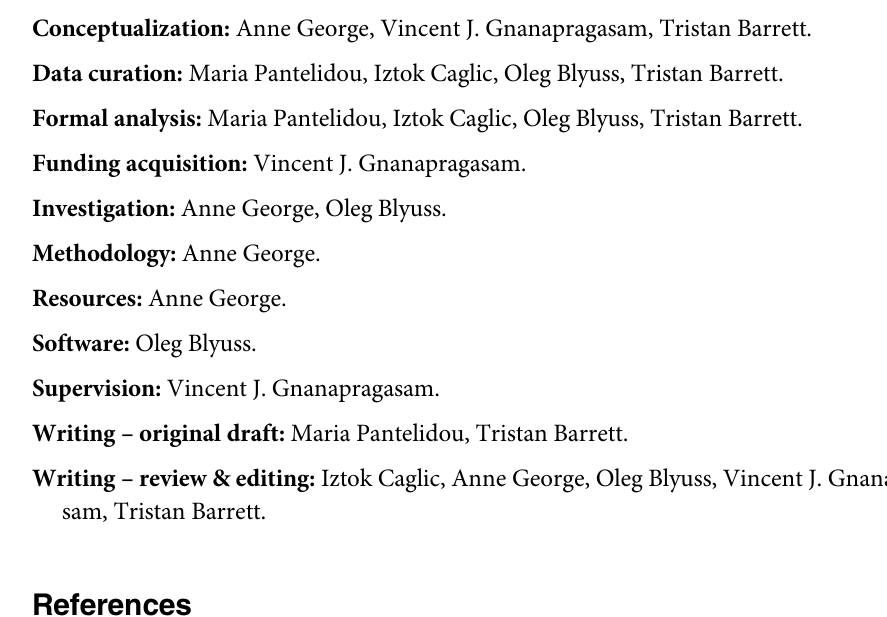
S1 Fig. Bland-Altman agreement of US-derived TP versus MRI-derived prostate volume. The middle solid line represents the mean agreement difference between MRI and US TP vol- umes, the lower line represents the lower limit of agreement between the two techniques ([mean– 1.96 standard deviation (SD) and the upper line represents the upper limit of agree- ment ([mean + 1.96 SD)] between the two techniques. S2 Fig. Bland-Altman agreement of US-derived TA versus MRI-derived prostate volume. The middle solid line represents the mean agreement difference between MRI and US TP vol- umes, the lower line represents the lower limit of agreement between the two techniques ([mean– 1.96 standard deviation (SD) and the upper line represents the upper limit of agree- ment ([mean + 1.96 SD)] between the two